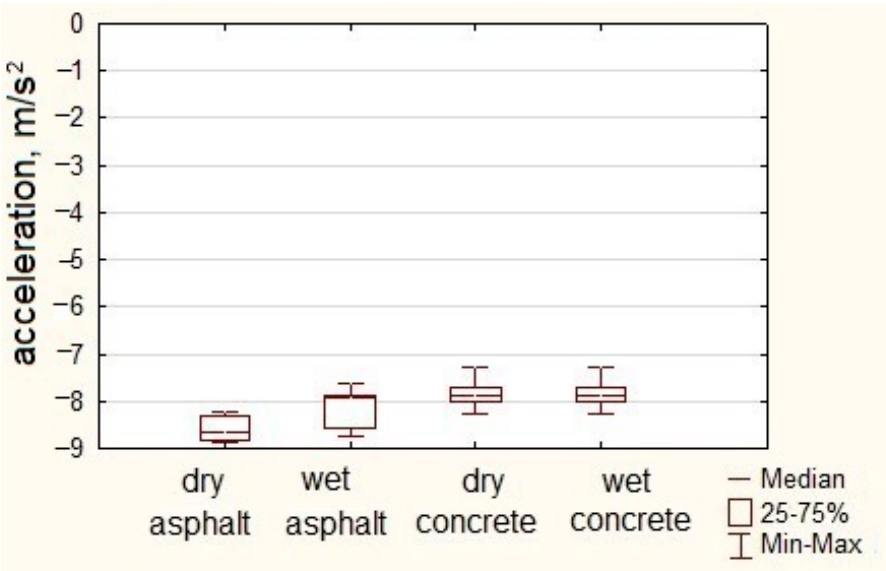
Figure 5. Longitudinal acceleration of coach during braking. When analyzing the braking tests of the coach on a dry concrete surface, the average minimum acceleration value was − 7.84 m/s 2 with a standard deviation of 0.29 m/s 2 . The lowest acceleration value noted in sudden braking tests of the coach on the concrete dry surface was − 8.25 m/s 2 . On the concrete wet surface, the average value of minimum acceleration was − 7.84 m/s 2 , and the standard deviation was 0.30 m/s 2 . The highest braking intensity on the concrete wet surface was − 8.24 m/s 2 . Table 3 presents selected statistical parameters of the coach acceleration value from braking maneuvers carried out on various surfaces. Table 3. Statistical characteristics of the acceleration value in the braking maneuvers of the coach.